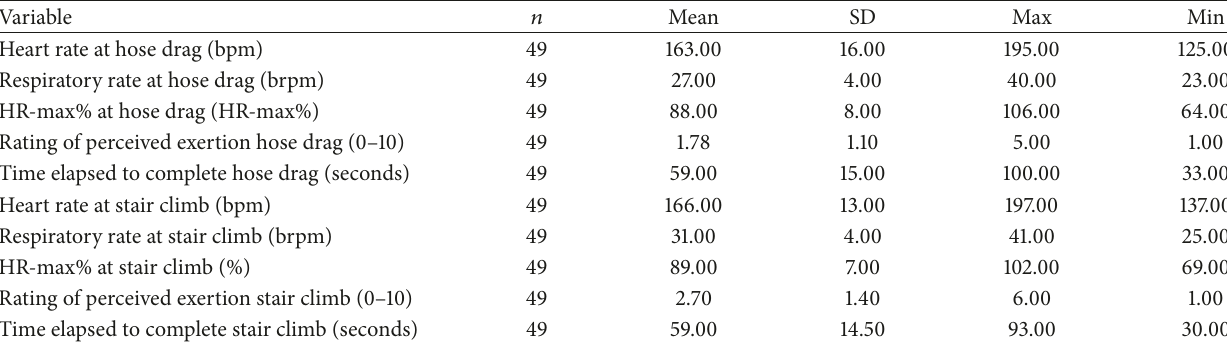
Table 2: Firefighters’ physiologic responses and task completion times.